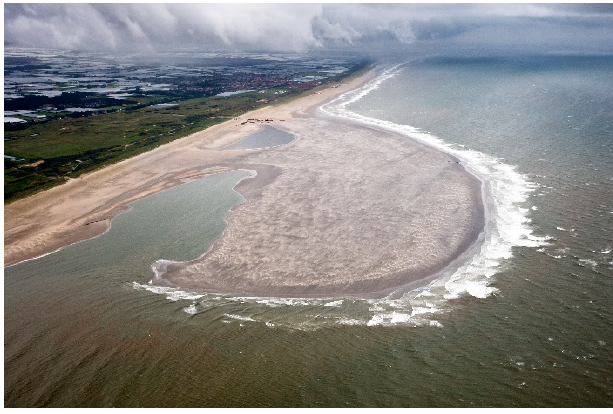
Fig. 1 . Sand Engine Delfland (https://beeldbank.rws.nl, Rijkswaterstaat / Joop van